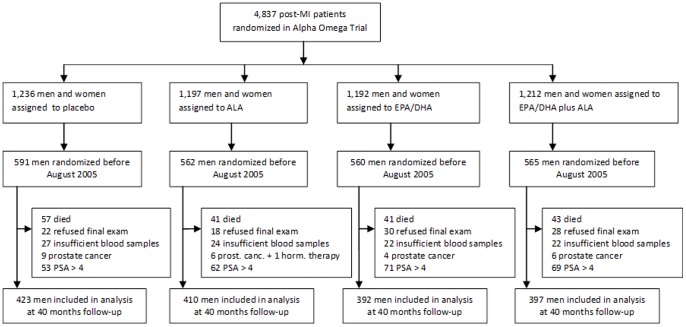
Participant flow for the study on effect of alpha linolenic acid (ALA) supplementation on PSA in post myocardial patients in the Alpha Omega Trial.